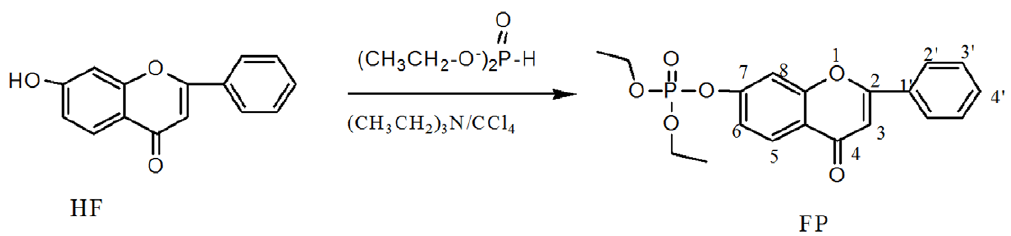
Figure 10. Scheme of diethyl flavon7-yl phosphate (FP) synthesized by a simplified Atheron-Todd reaction.